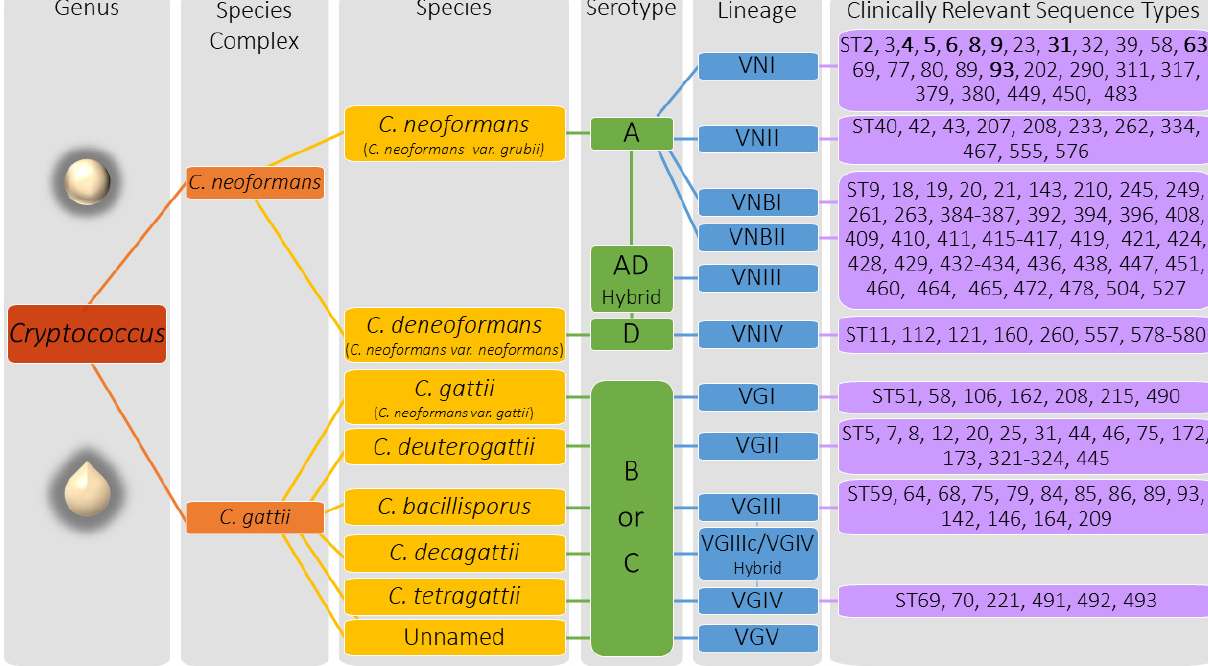
Figure 2. The Cryptococcus species complex. Cryptococcal strains are distinguished by species complex, species, serotype, molecular type or lineage, and sequence type. Bold text indicates the Sequence Types that are observed more frequently among clinical isolates (i.e., ST2, ST4-ST9, ST31, ST63, ST93) in certain geographical regions. Genus panel shows the difference in cryptococcal cell shapes that occur in each species complex; C. neoformans strains are often round in shape and C. gattii strains can have an oval to teardrop shaped morphology [2].